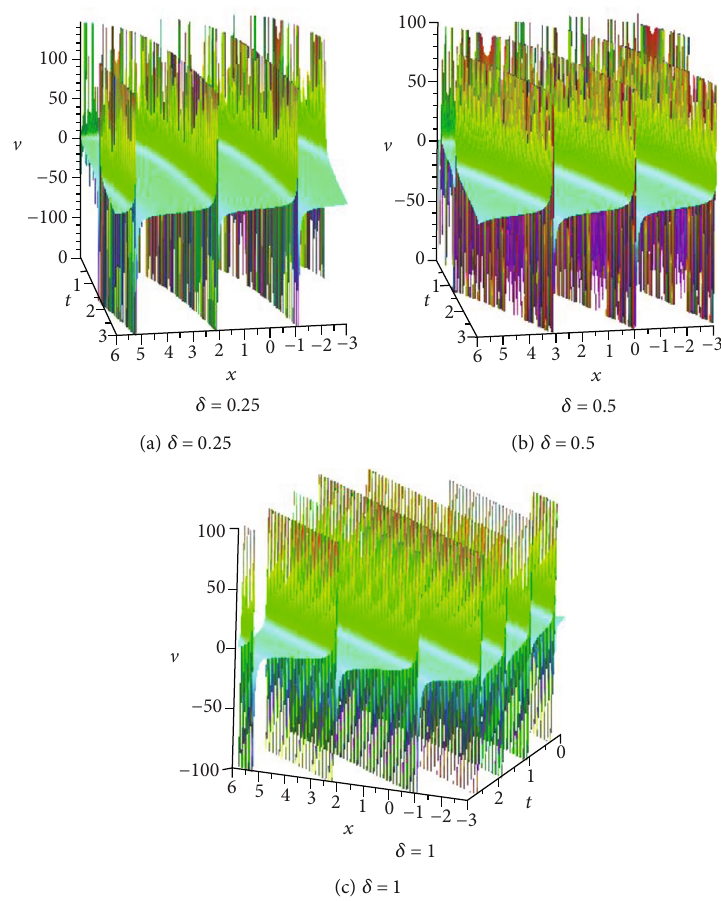
Figure 9: Periodic wave solution for A = a = 1 of (43): (a) for δ = 0 : 25 , (b) for δ = 0 : 5 , (c) for δ = 1 : (a, b) curvy surface for fractional order, (c) straight surface for complete order.